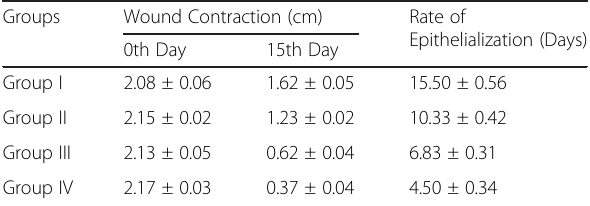
Table 3 Rate of Wound Contraction and Epithelialization in experimental animals